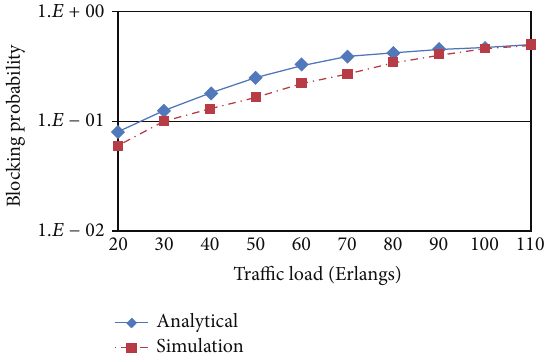
Figure 4: Blocking probability with network traffic